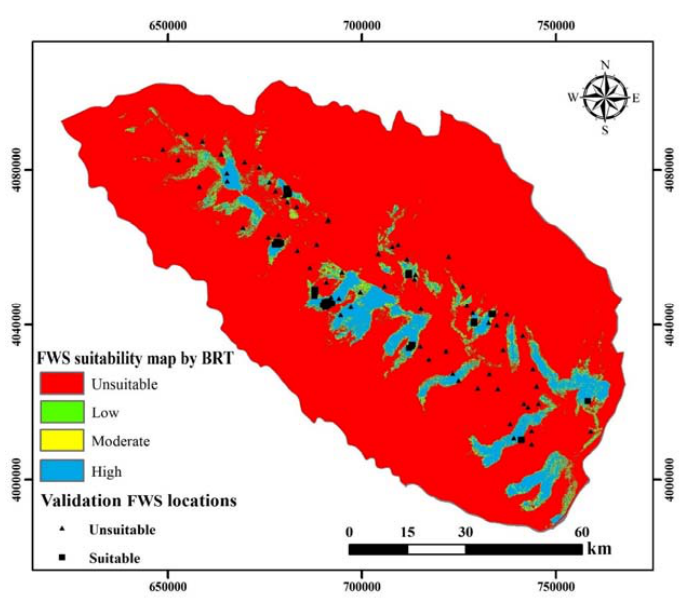
Figure 6. The tuning results of the BRT algorithm.